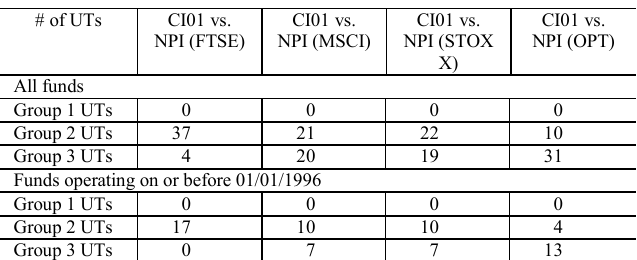
Table 1: Hypothesis